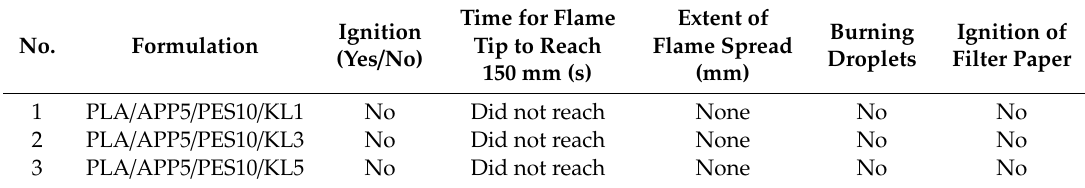
Table 9. Ignitability test results of nonwoven fabric samples.